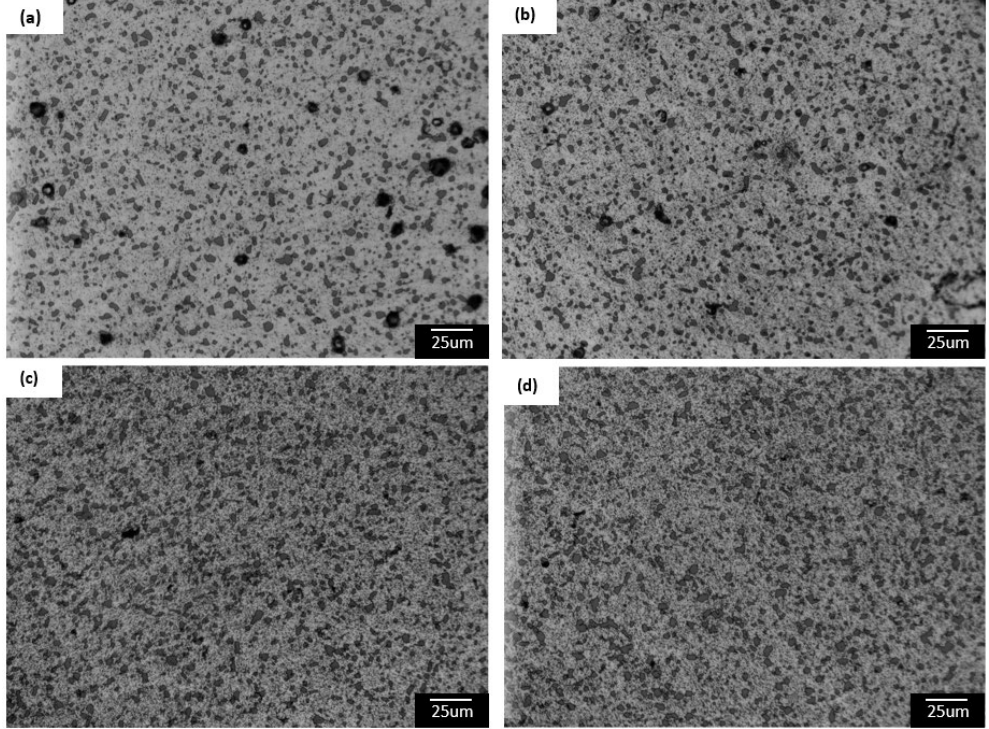
Figure 6. Optical micrographs of specimens artificially aged at ( a ) 140 °C and 11 h ( b ) 140 °C and 12 h ( c ) 160 °C and 7 h ( d ) 160 °C and 8 h.